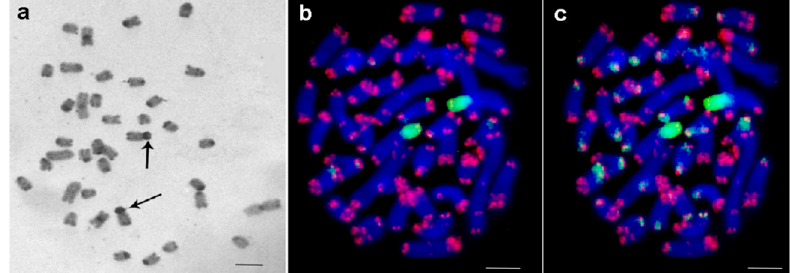
Figure 1. Metaphase plates of female embryo of Medauroidea extradentata . ( a ) C-banding: large submetacentrics have in their short arms proximal C-positive regions, indicated by arrows is thepair with the largest C-positive regions; ( b ) Fluorescence in situ hybridization (FISH) with 18S ribosomal deoxyribonucleic acid (rDNA) (green) and telomeric repeats (red) showed that the in ( a ) highlighted chromosome pair has rDNA accumulated in C-positive region. Chromosomes were counterstained by 4 ′ ,6-diamidino-2-phenylindole (DAPI) (blue). ( c ) The same metaphase as in ( b ), but with longer exposure time for green channel, is shown. Other chromosomal regions also gave weak signals using 18S rDNA specific probe. Scale bar indicates 5 μ m.